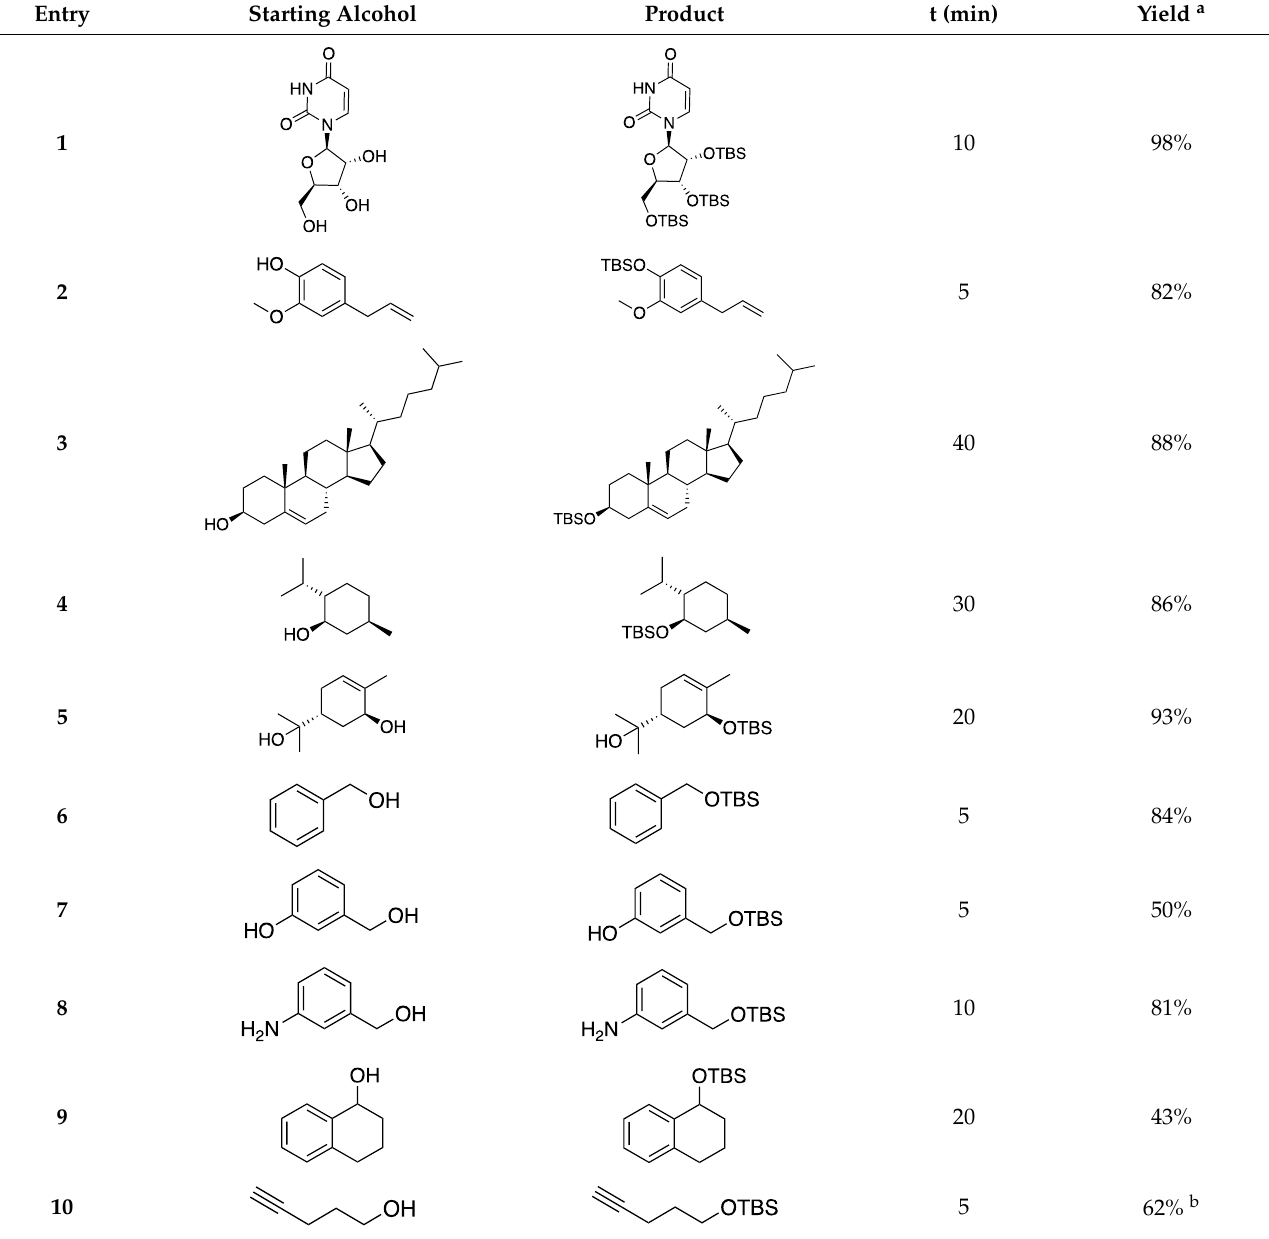
Table 2. Silylation of alcohols using the TBDMSCl/DBU/KNO 3 reagent system.